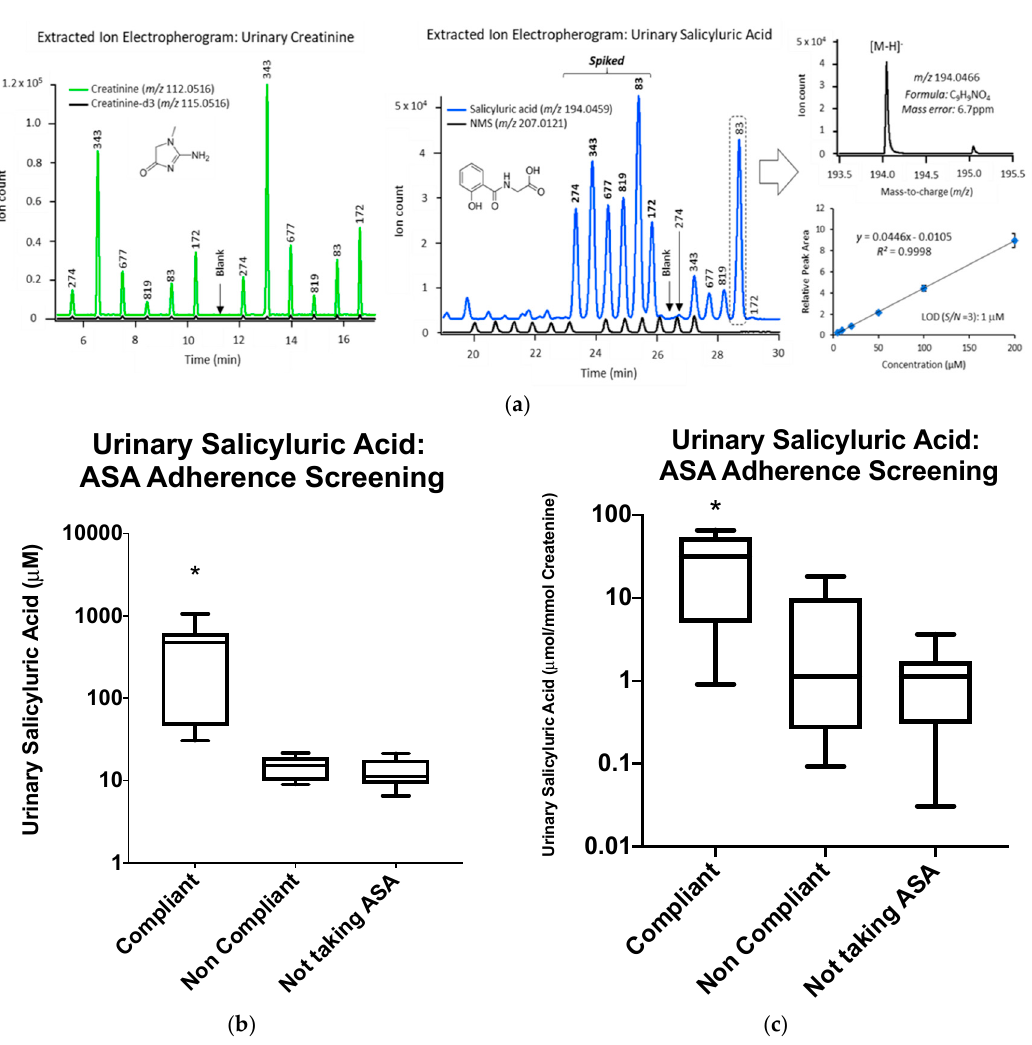
Figure A1. ( a ) Extracted ion electropherograms for multiplexed analyses of salicyluric acid (SU) and creatinine simultaneously by multisegmented injection-capillary electrophoresis-mass spectrometry (MSI-CE-MS) under negative ion mode conditions, which were confirmed by their accurate mass and co-migration after spiking urine samples with authentic standards. ( b ) SU analysis of 17 patients with platelets not inhibited by 81 mg ASA and 12 controls not taking 81 mg ASA. ( c ) Concentration distributions for SU normalized to creatinine (µmol/mmol) in 17 patients with platelets not inhibited by 81 mg ASA and 12 controls not taking 81 mg ASA. Significant difference of SU levels between compliant and non-compliant patients is represented by (*) with p < 0.05.